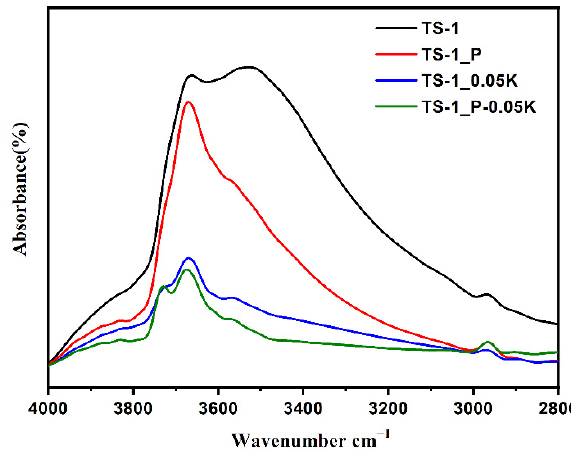
Figure 5. FTIR spectra of hydroxyl groups of various TS-1 samples.